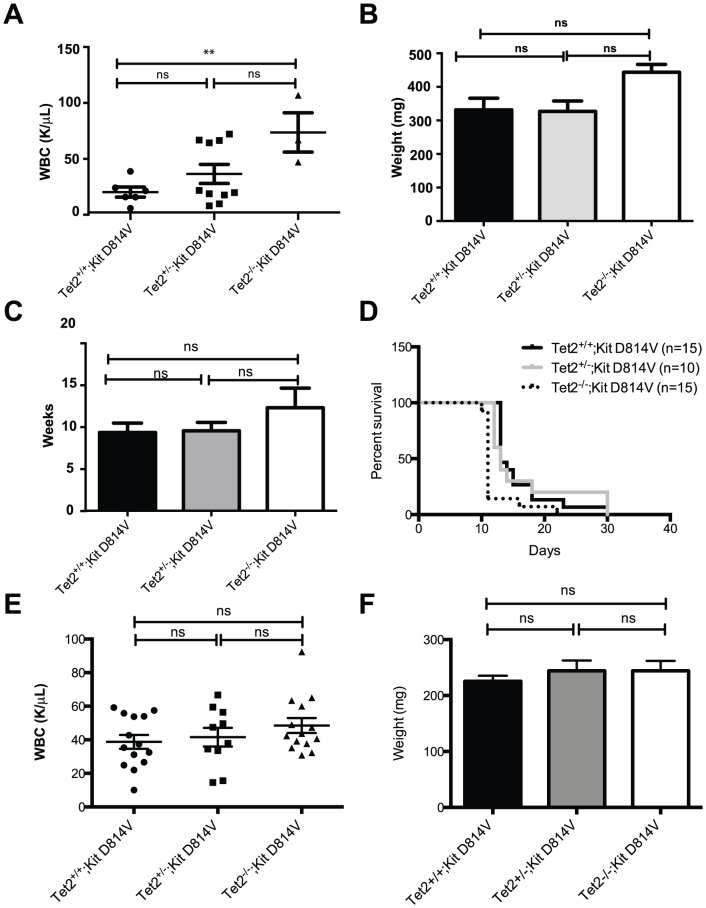
Tet2 deletion affects progression but not initiation of Kit D814V-driven ALL.
A) Leukocyte counts in moribund leukemic animals according to genotype. Each data point represents an individual animal. **P<.01. B) Leukemic infiltration of the spleen expressed as weight (in mg) across genotypes. C) Latency of disease (expressed as weeks after the last pI:C injection when mice were found moribund) across genotypes. Data in A B, C is presented as mean ±SEM (n = 3–12 per group). D) Kaplan-Meier plot demonstrating survival of recipients transplanted with Tet2+/+;Kit D814V (black line),Tet2+/−;Kit D814V (grey line) and Tet2−/−;Kit D814V (black dotted line) lymphoid leukemic blasts (median survival, 13, 13 and 11 days respectively, n = 10–15 per group, P = .009). E) Leukocyte counts in secondary moribund leukemic animals according to genotype. Each data point represents an individual animal. F) Leukemic infiltration of the spleen expressed as weight (in mg) across genotypes of secondary animals. ns  =  not significant.